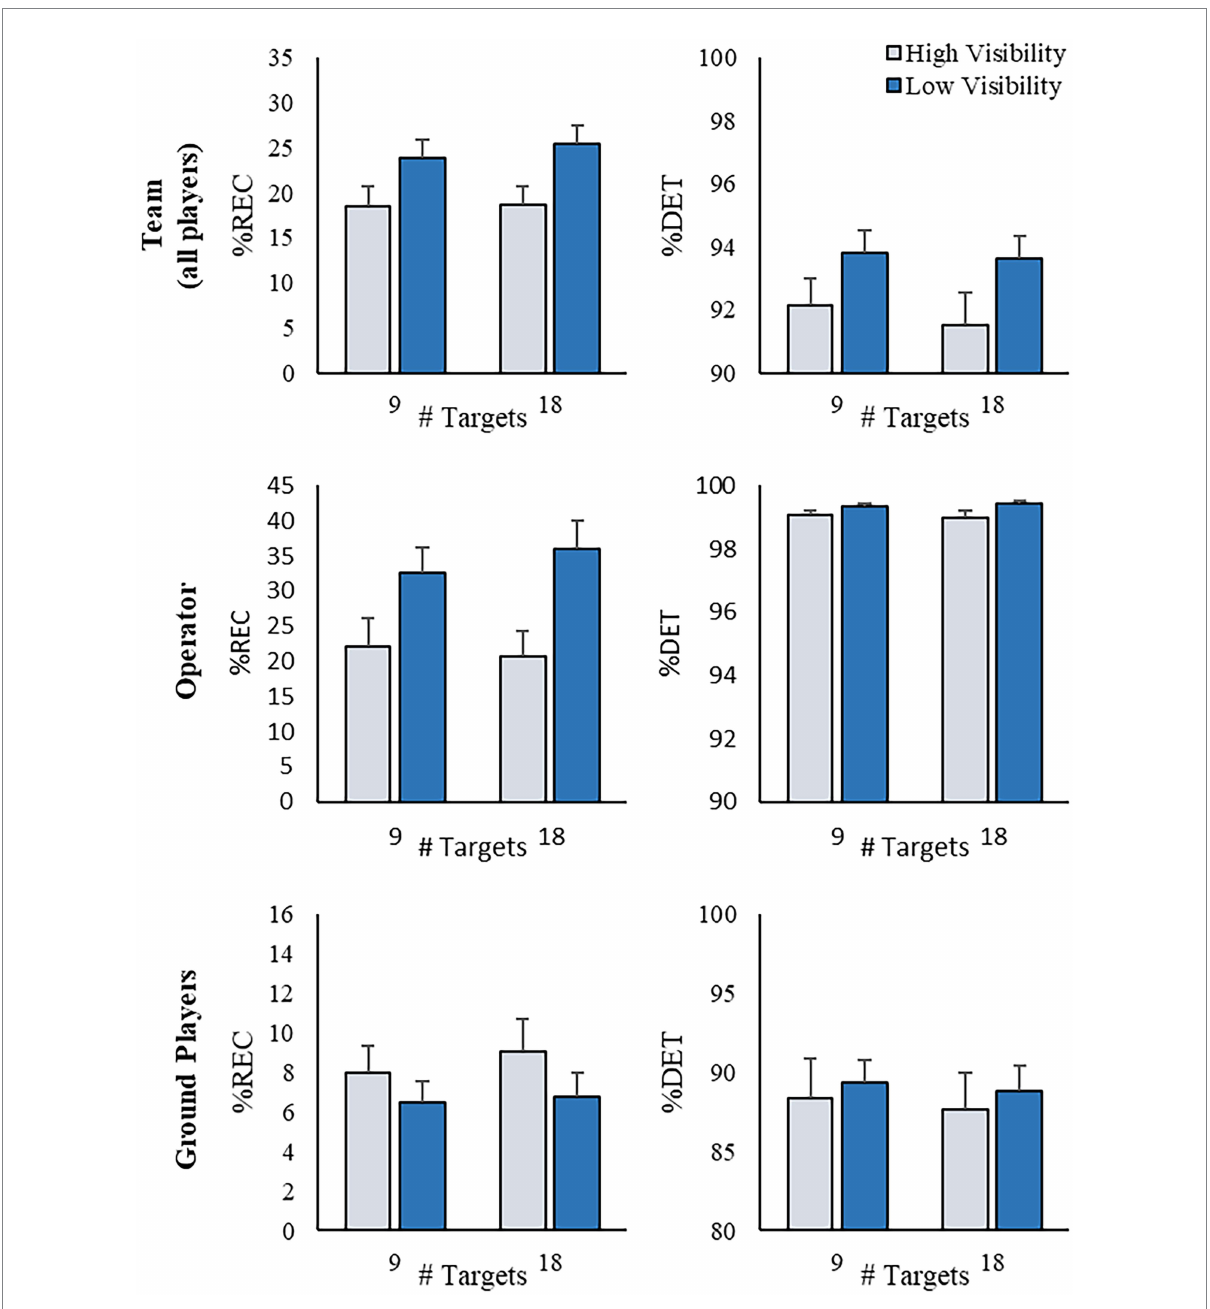
FIGURE 7 Summary of catRQA results. Mean %REC and %DET for the team (top), operator (middle) and ground player (bottom) communication data series as a function of the target number and visibility conditions. Error bars represent the standard error of the